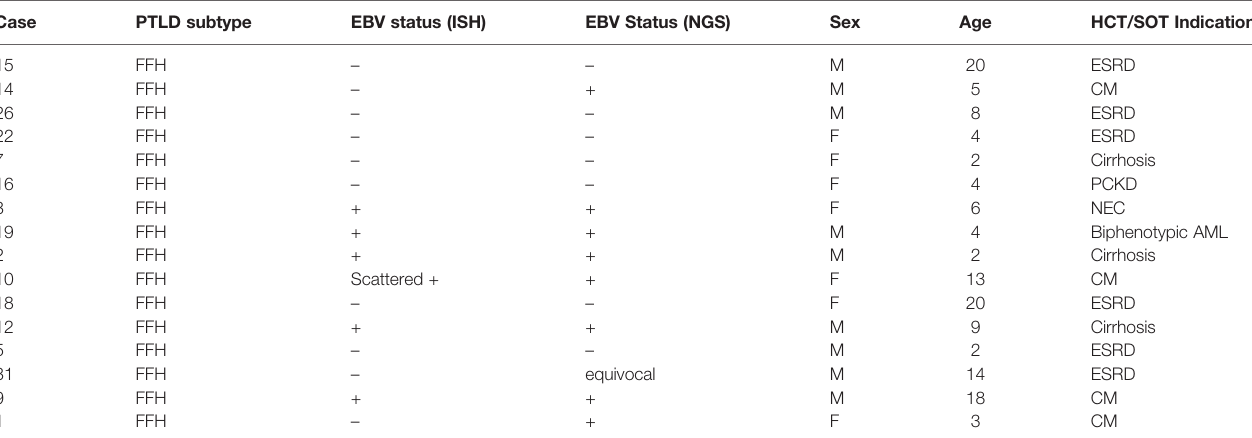
TABLE 2 | Clinical and histological characteristics of the patients with fl orid follicular hyperplasia included in study.